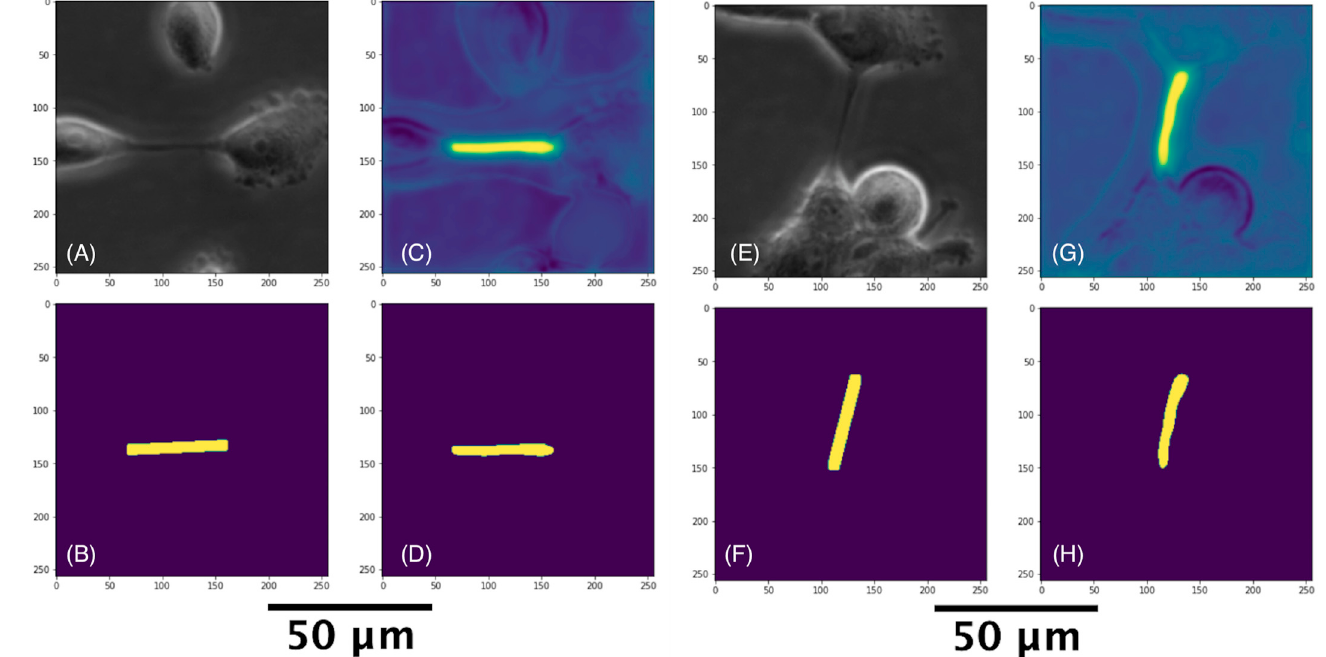
Figure 5. TNTs detected from two cropped images. ( A , E ) are the cropped raw images. ( B , F ) are the manually marked labels. ( C , G ) are the heatmap versions after prediction. ( D , H ) are the predicted TNTs.